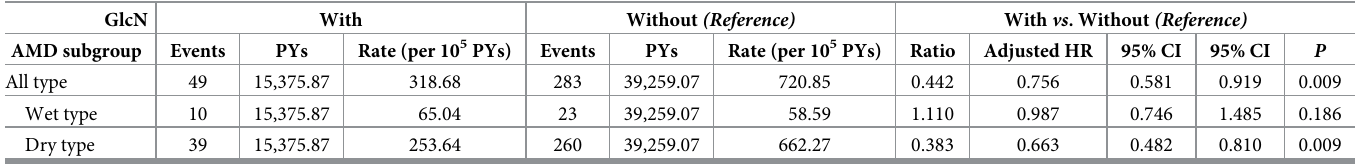
Table 4. Stratified Cox regression analyses according to AMD type. GlcN With Without (Reference) With vs . Without (Reference) AMD subgroup